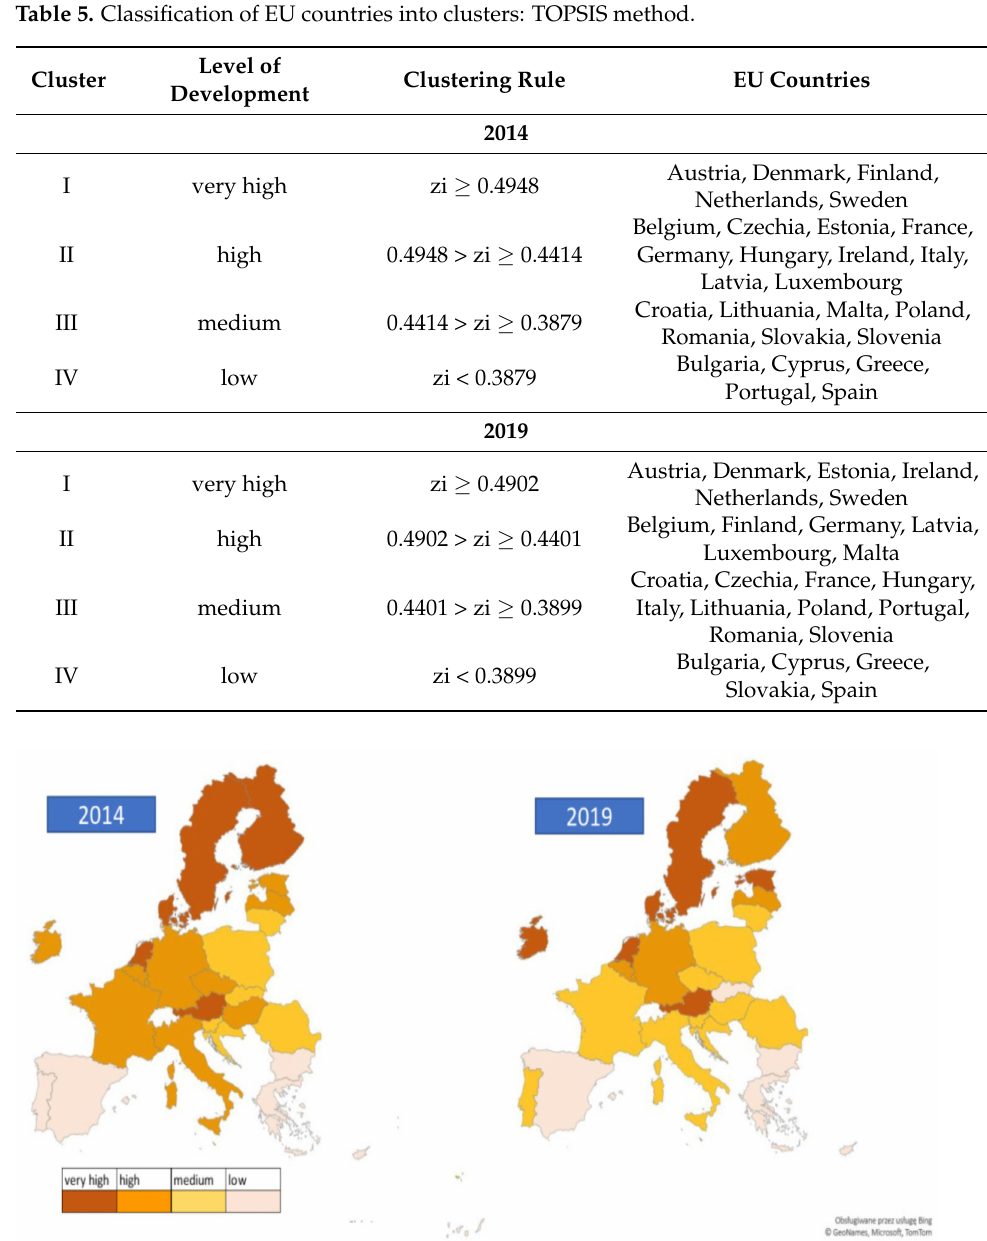
Figure 2. Classification of EU countries into clusters: TOPSIS